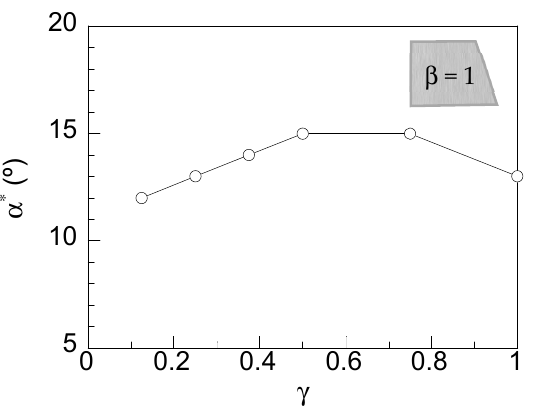
Figure 11. Variation of the transition chamfer angle as a function of the hub thickness, γ .